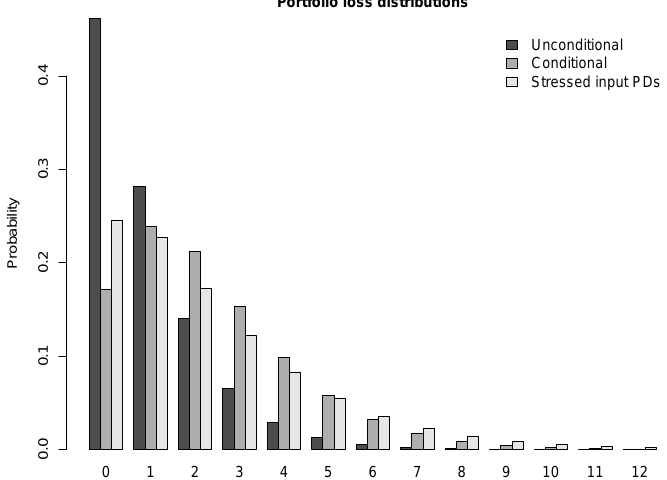
Figure 1. Unconditional, conditional on two defaults and “stressed input PDs” distributions of the number of defaults in portfolio of 100 obligors. All obligors have unconditional PD 1%. The model is one-factor CreditRisk + with factor standard deviation 0.8.